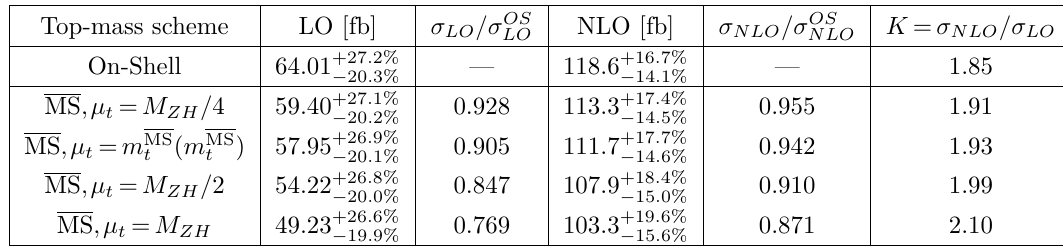
Table 1. Total cross section at LO and NLO with full top-quark mass dependence using different top-quark-mass renormalization schemes. The central value of the renormalization and factorization scales is fixed to be µ R = µ F = M ZH / 2 . Scale uncertainties are taken from a 7-point scale